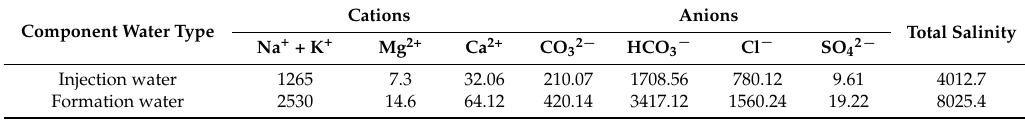
Table 5. Water composition of the injection and formation water (mg/L).